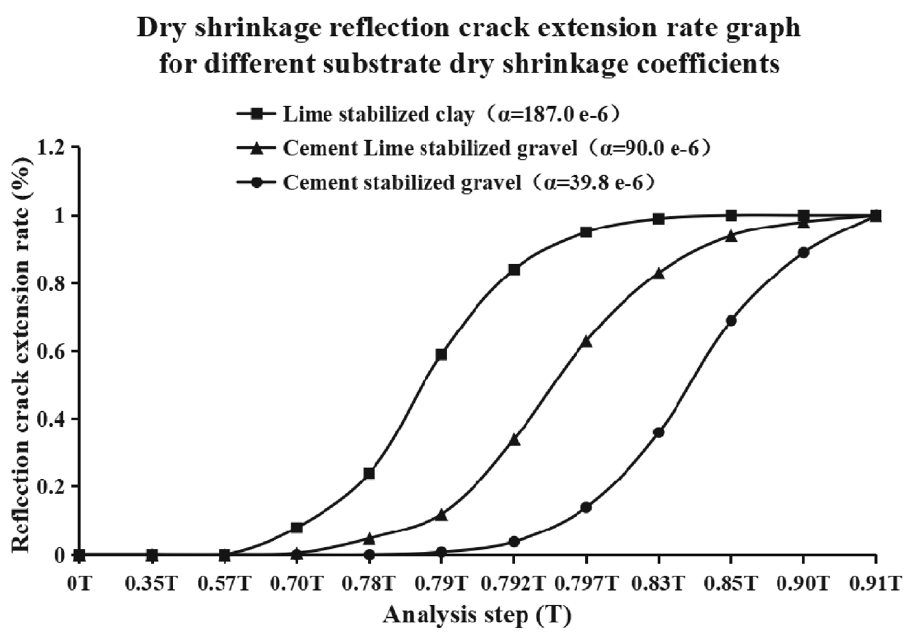
Fig. 11 The extension rate of dry shrinkage reflective cracks with different base dry shrink- age